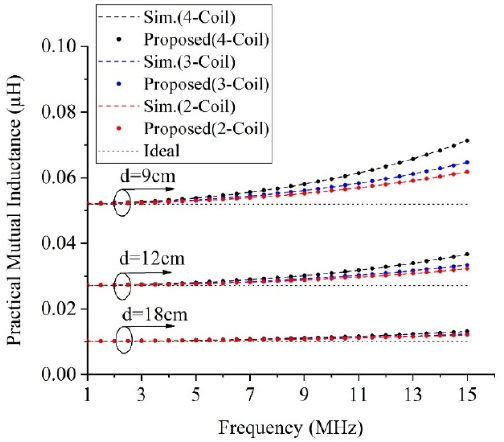
Figure 10. Practical mutual inductances between side coils.